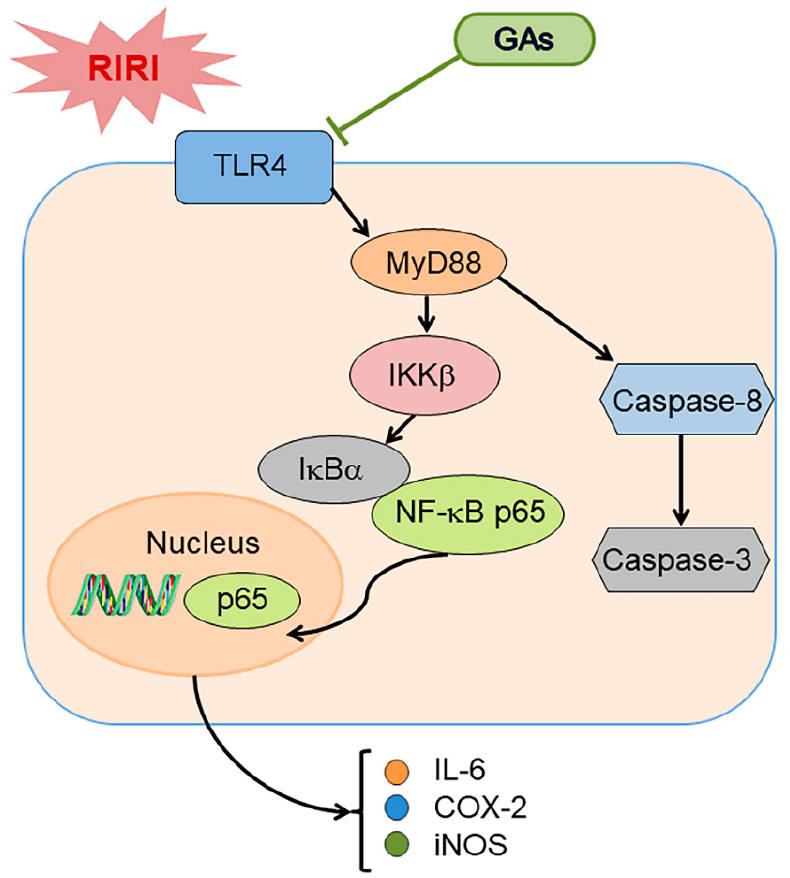
Figure 7. Schematic diagram of the signal pathways involved in RIRI-induced renal injury and proposed effects of GAs on RIRI. Please see the text for explanations.